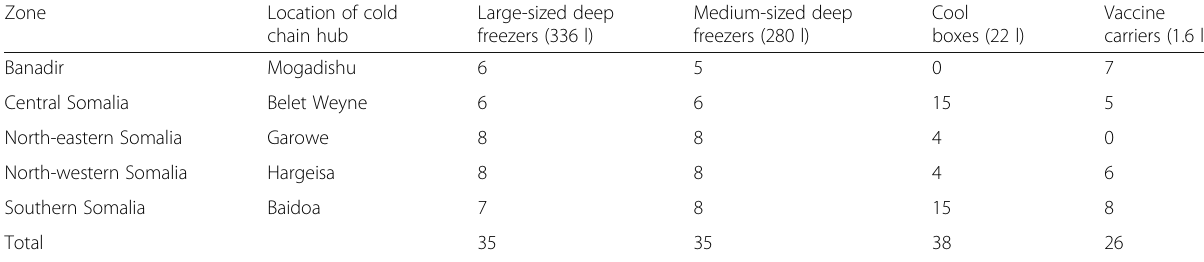
Table 4 Distribution of cold chain equipment in the five zones of Somalia, 2012